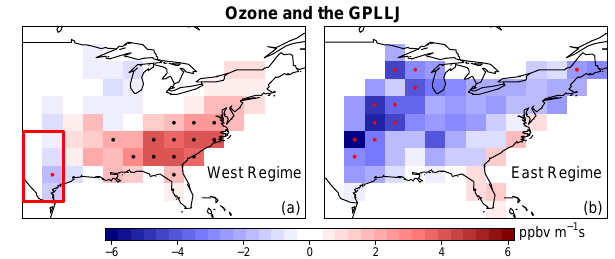
Figure 7. Slopes of anomalous JJA MDA8 ozone vs. GPLLJ in the summers when the Bermuda High is characterized by the (a) West Regime and (b) East Regime during 1980–2012. Ozone concentra- tions have been detrended as described in text. The West Regime refers to the summers when the west edge of the Bermuda High is located to the west 85.4 ◦ W, while the East Regime is when the west edge is located east of this longitude. See text for further de- tails. Dots indicate grid boxes where the slope is significant at the 0.10